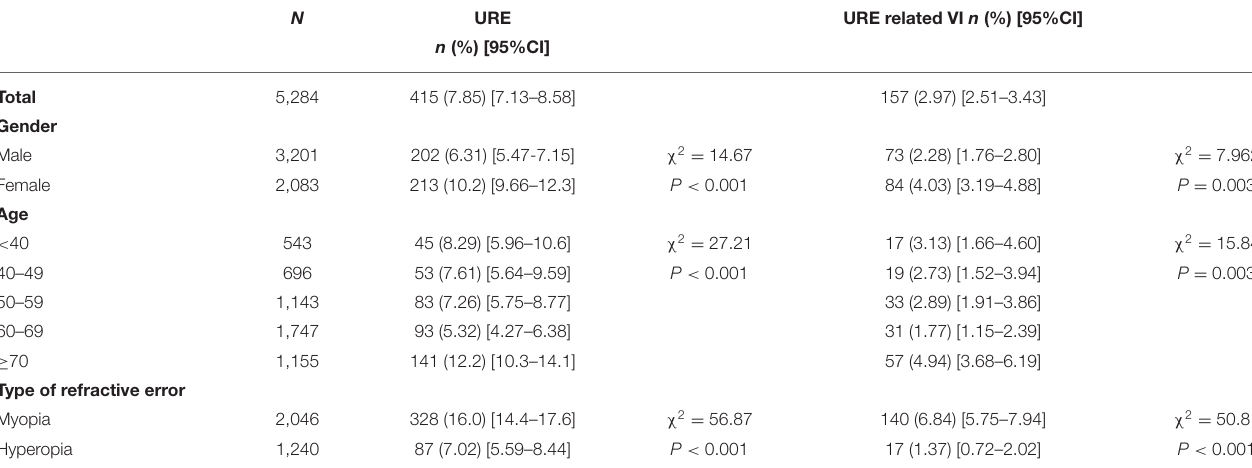
TABLE 2 | The prevalence of uncorrected refractive error (URE) and URE-related visual impairment (VI) according to the age, gender, and type of